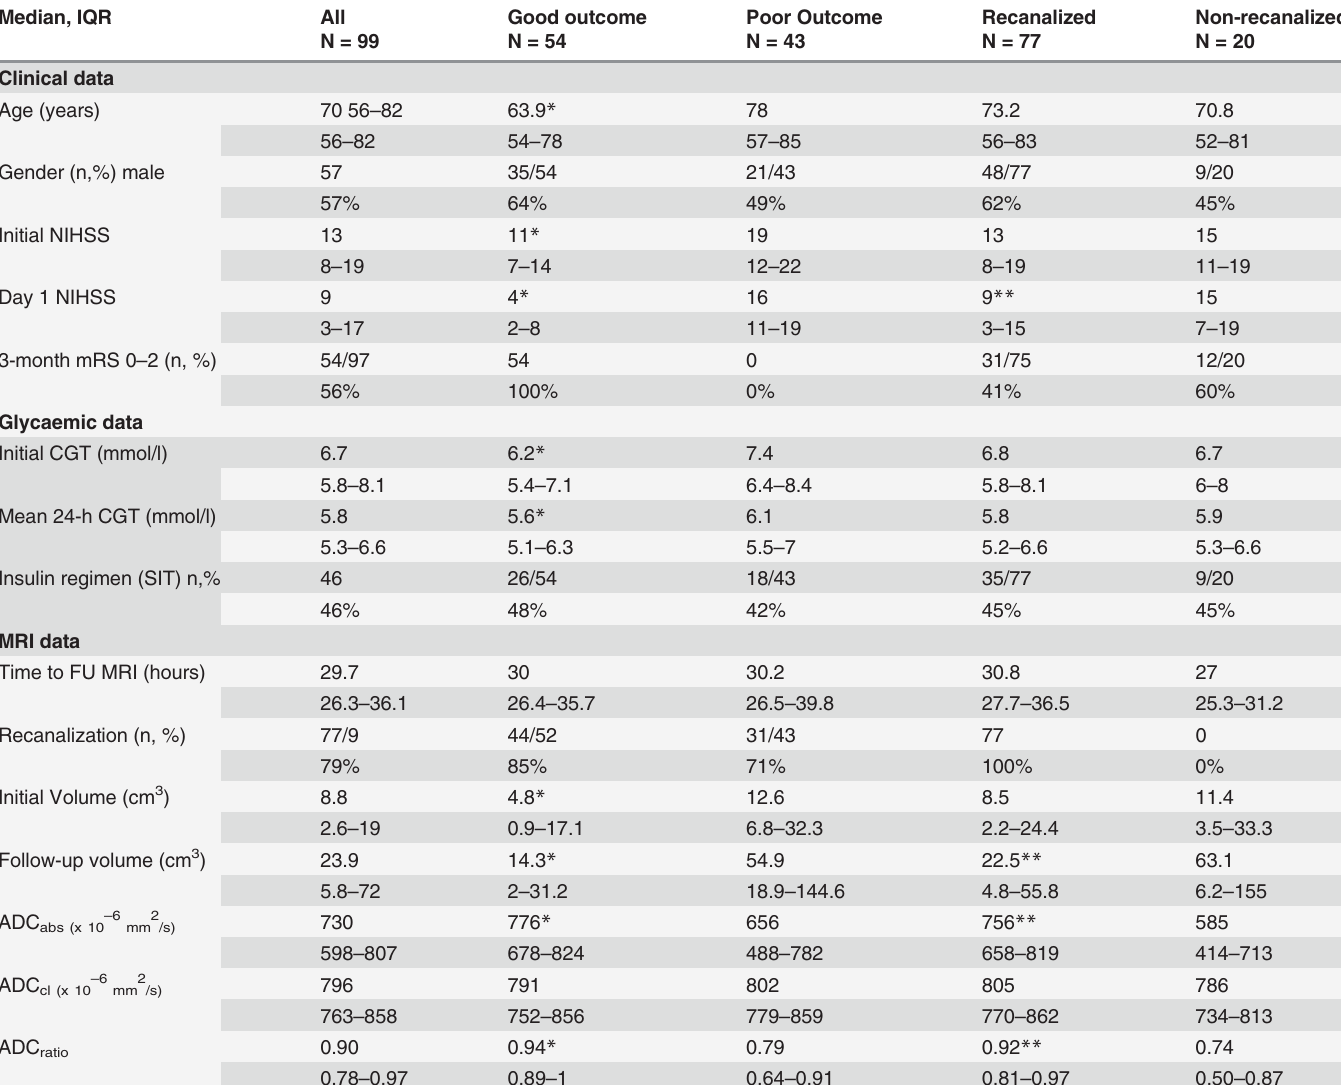
Table 1. Characteristics of the